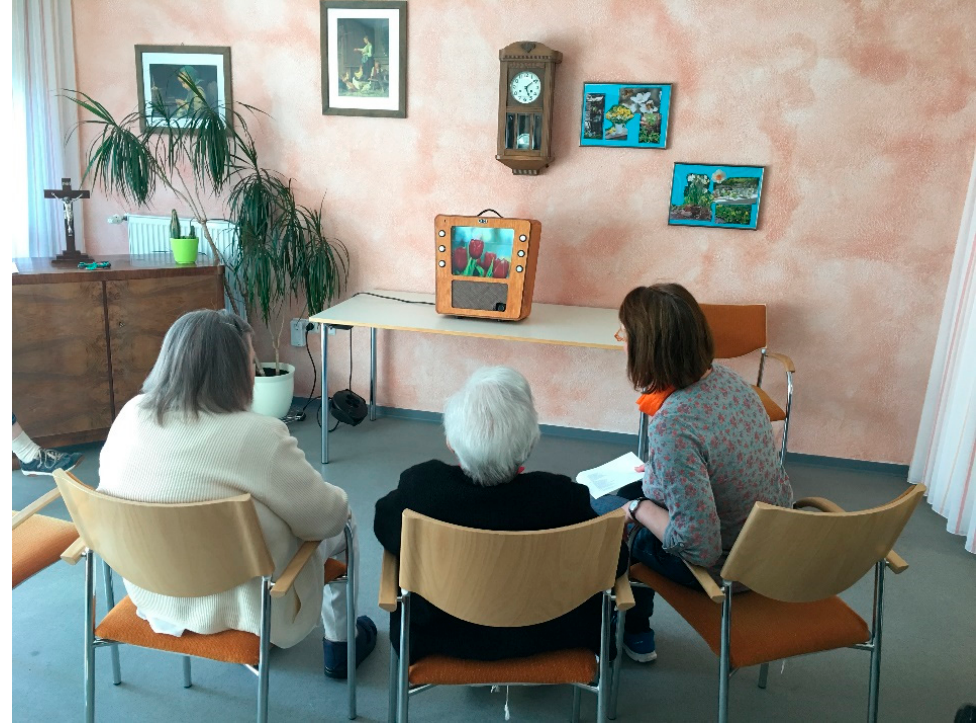
Figure 9 . The “Jukebox” in a nursing home setting. Figure 9. The “Jukebox” in a nursing home